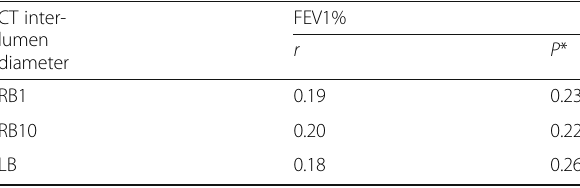
Table 3 Correlation of FEV1% and intraluminal size